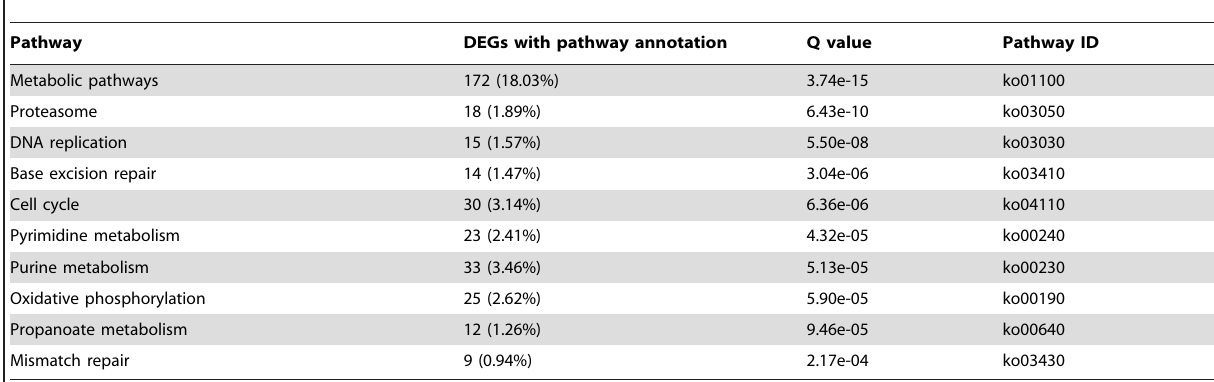
Table 3. Top 10 significantly enriched pathways at + 3 d compared with 2 7 d.